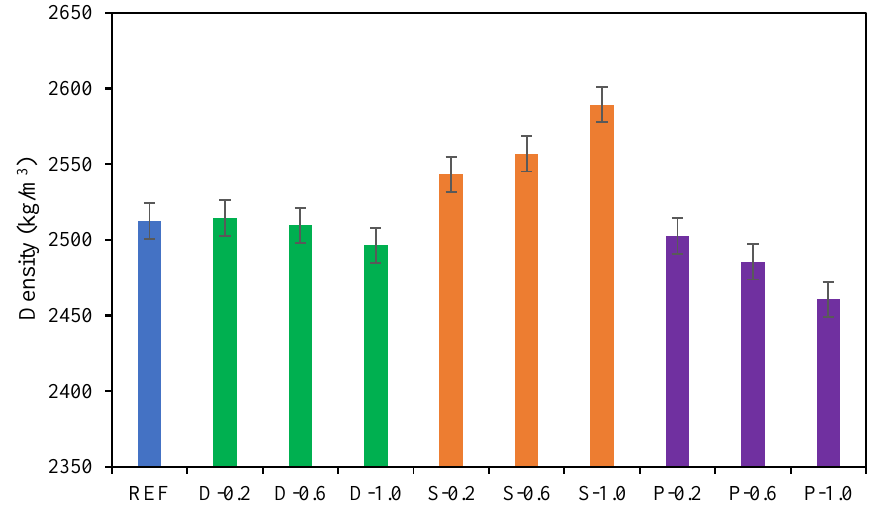
Figure 10. Densities of fibrous concrete samples.